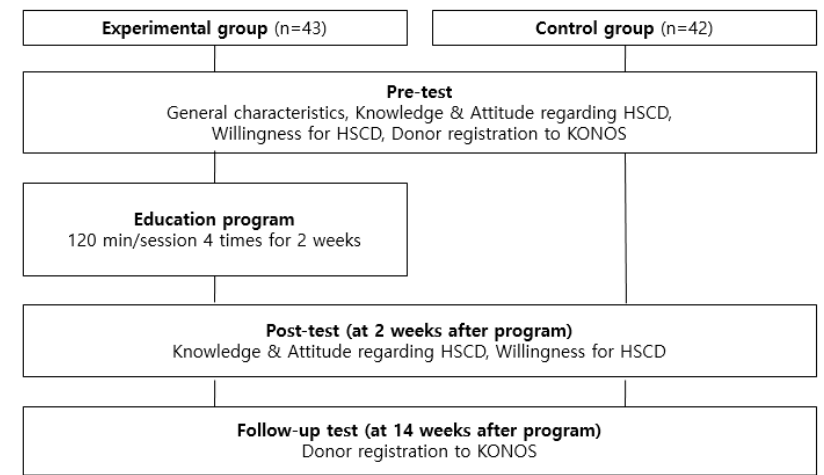
Figure 1. Flow of the study (HSCD: Hematopoietic Stem-Cell Donation, KONOS: Korean Network for Organ Sharing).